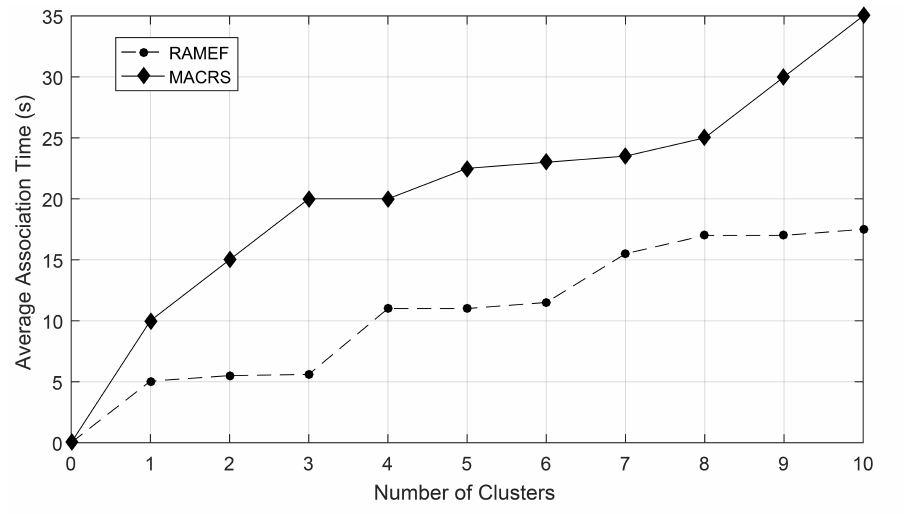
Figure 11. Average association time for a single node.